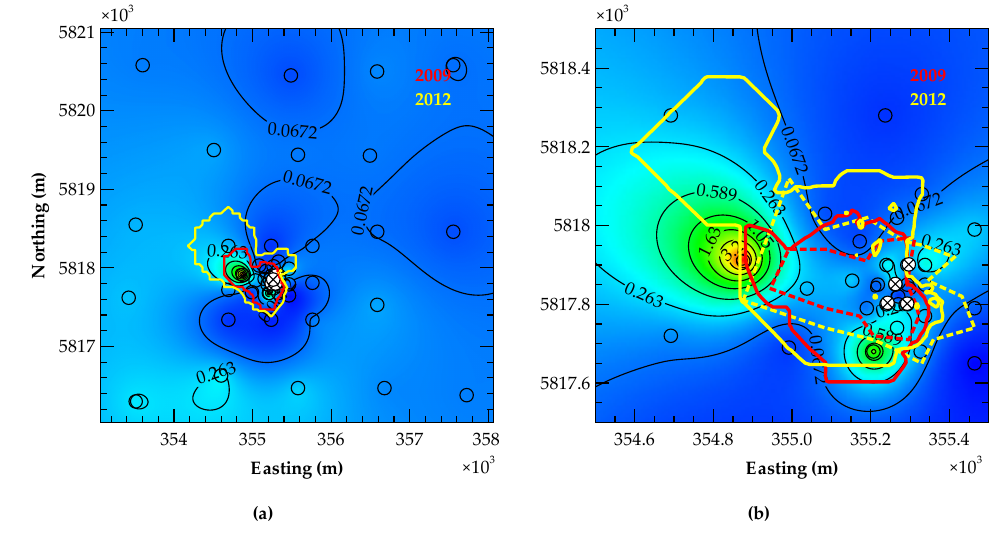
Figure 6. ( a ) Plan view of simulated gaseous CO 2 extent in 2009 (red solid line) and 2012 (yellow solid line). ( b ) Close-up plan view of gaseous CO 2 extent detected by 3D seismics in 2009 (detection threshold 5 m, red dashed line) and 2012 (detection threshold 7.5 m, yellow dashed line), and simulated gaseous CO 2 thickness contours for 2009 (5 m thickness, solid red line) and 2012 (7.5 m thickness, solid yellow line). Empty circles represent pilot points, white-filled circles with crosses well locations including the well Ktzi 203 located in between Ktzi 201 and Ktzi 202. Blue-to-red contours show the permeability multipliers determined by inverse model calibration (UTM-WGS84